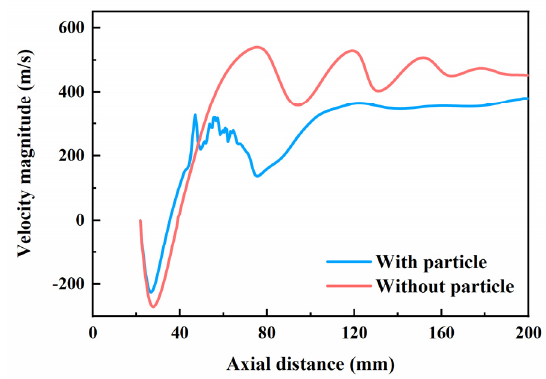
Figure 8. Axial velocity curves of the gas field with and without particle injection.